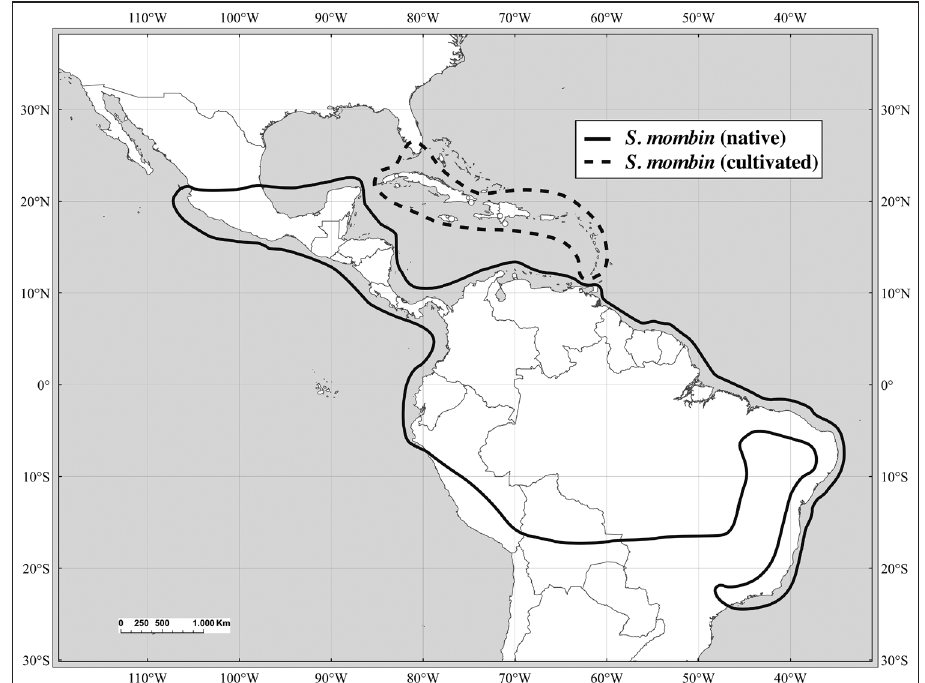
Figure 12. Distribution of Spondias mombin